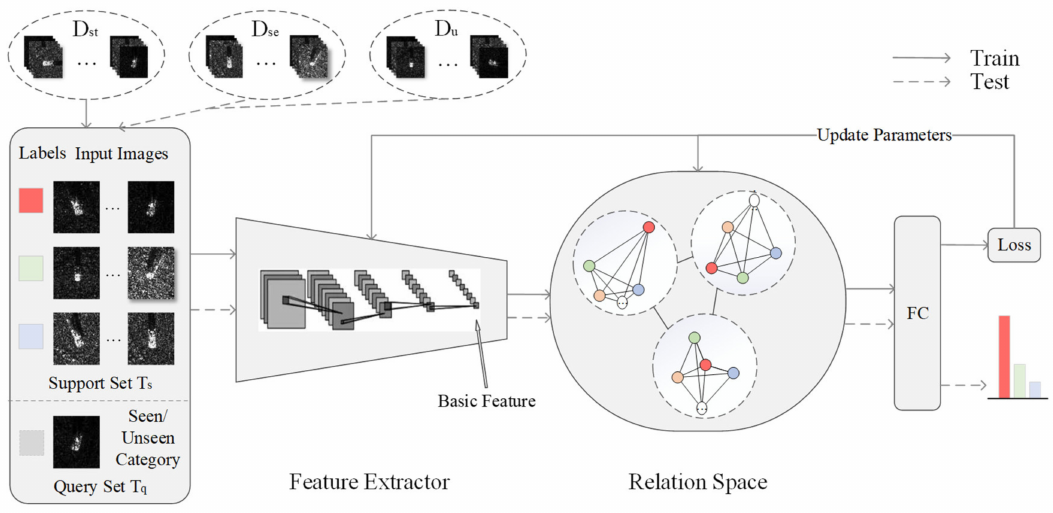
Figure 1. The model